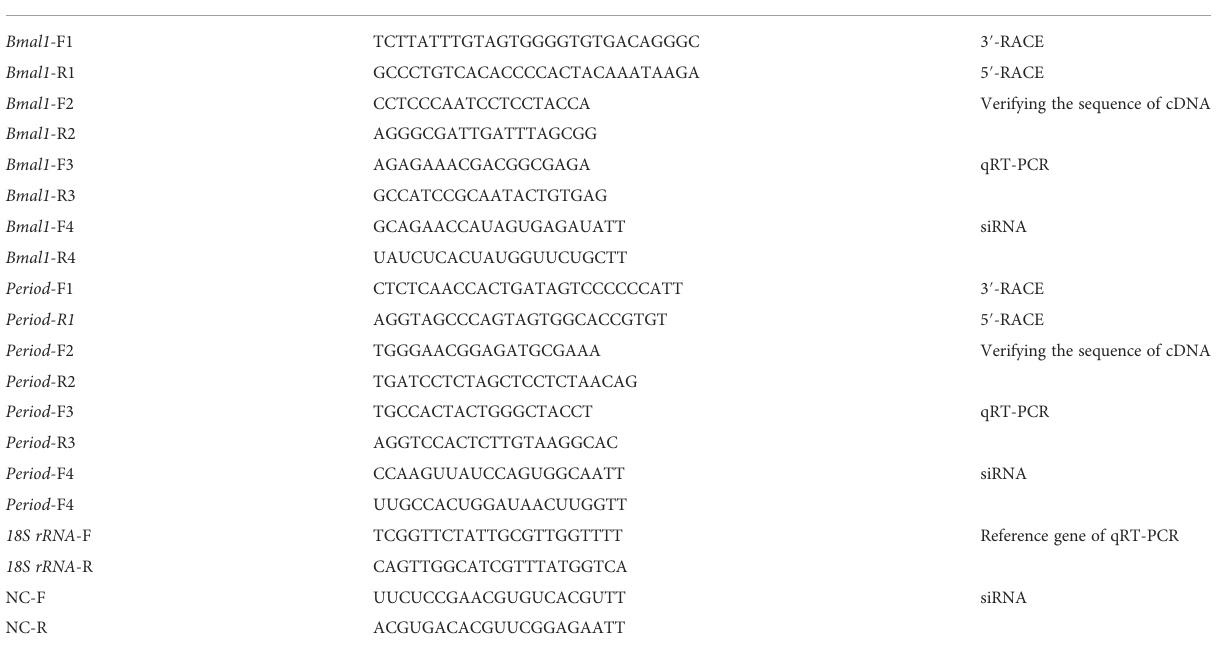
TABLE 1 All primer sequences used in the experiments. Primers Sequences (5 ′ -3 ′